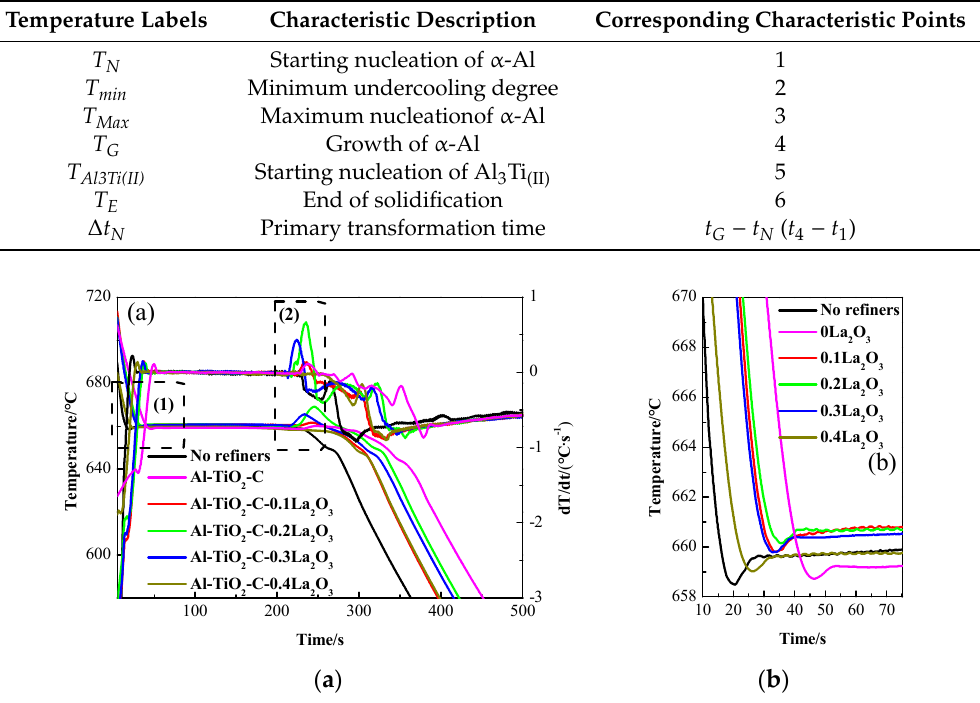
Figure 11. ( a ) The cooling curve of the industrial aluminum refined by the Al-TiO 2 -C-XLa 2 O 3 refiner; ( b ) Area 1. ( b ) Area